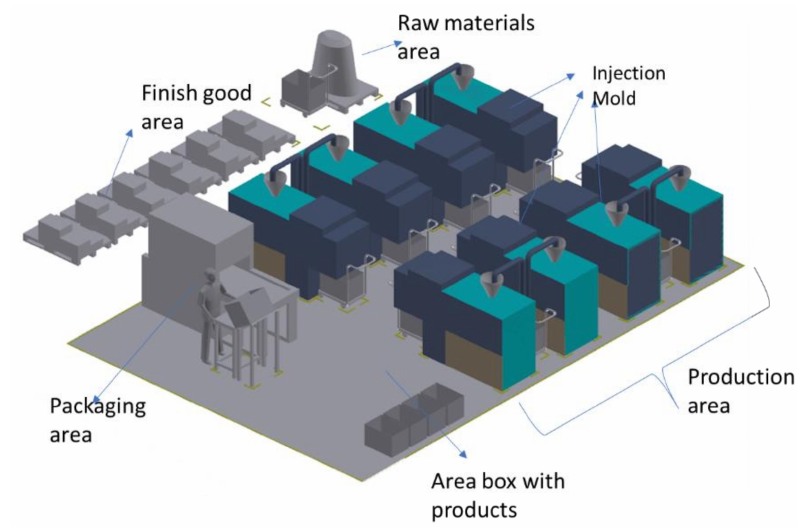
Figure 26. Standardized production